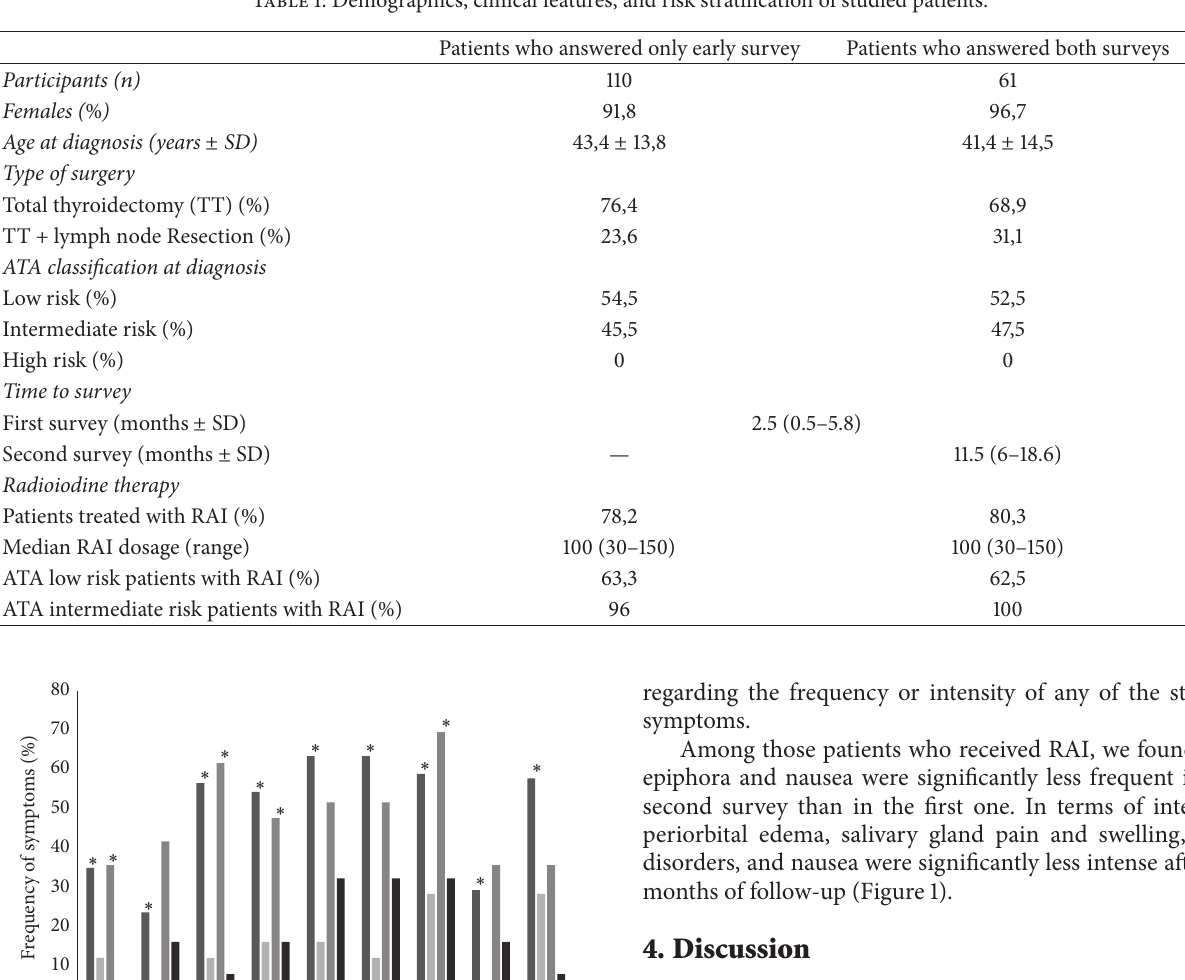
Table 1: Demographics, clinical features, and risk stratification of studied patients.